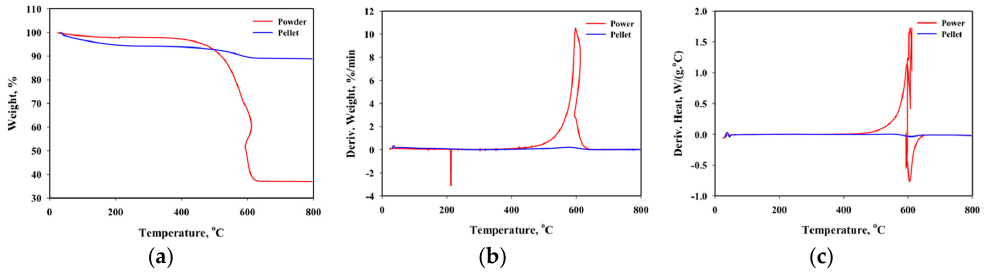
Figure 9. The results of temperature programmed oxidation (TPO) tests for powder and pellet catalyst samples, corrected after steam reforming of toluene over Ni–Mg–Ce–Zr/Al 2 O 3 at 800 °C and S/C = 3.0: ( a ) thermogravimetric analysis curves, ( b ) derived weight, and ( c ) derived heat.